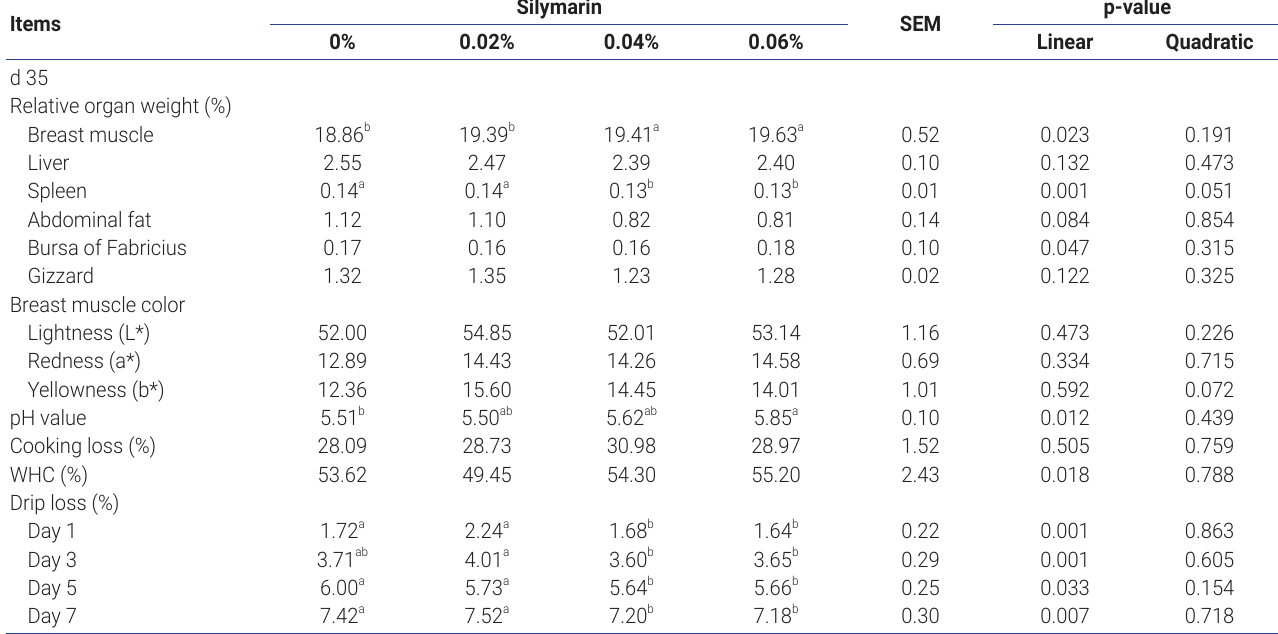
Table 7. The effect of Silymarin supplementation on organ weight and meat quality in